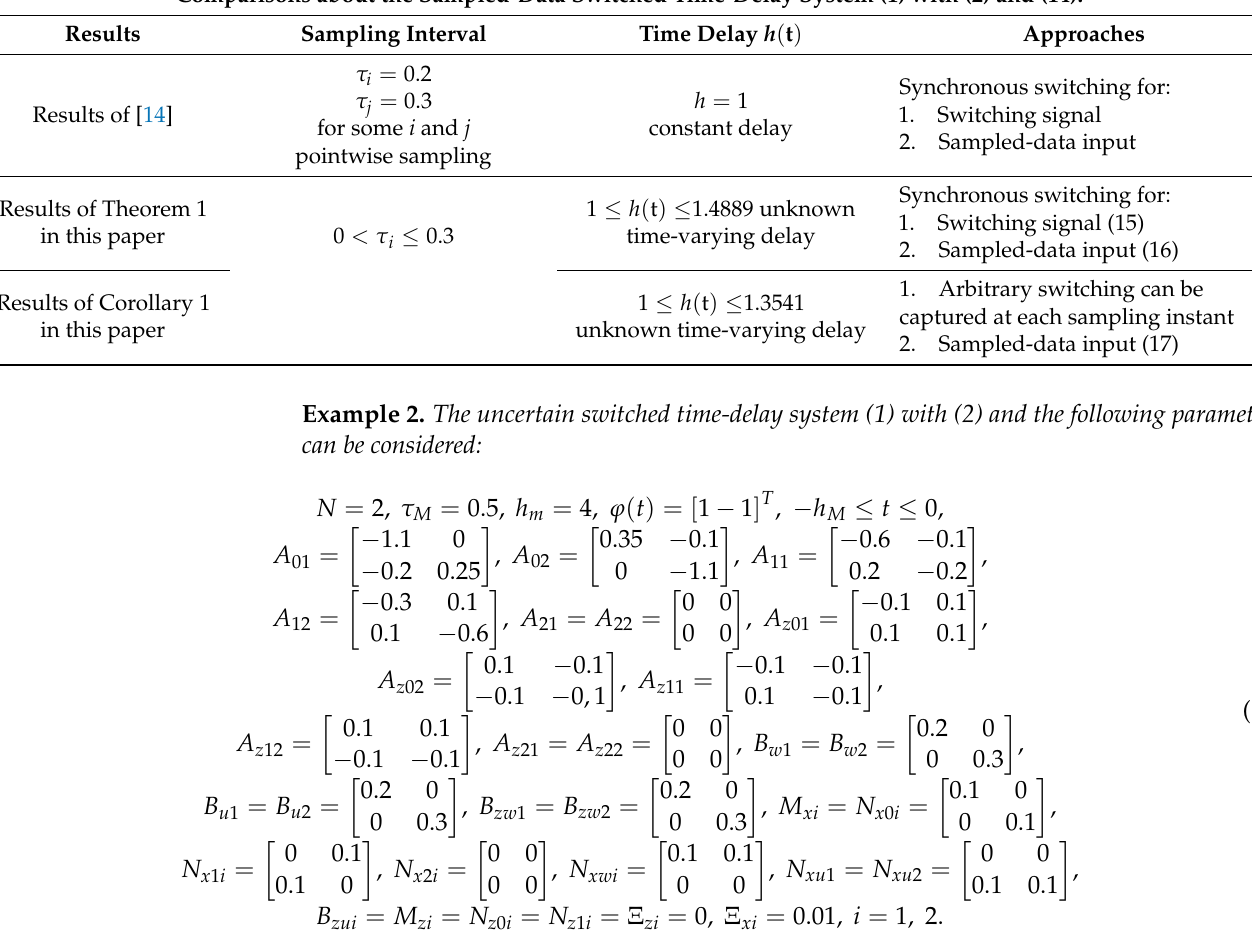
Table 1. Comparisons of switched time-delay system (1) with (2) and (14). Comparisons about the Sampled-Data Switched Time-Delay System (1) with (2) and